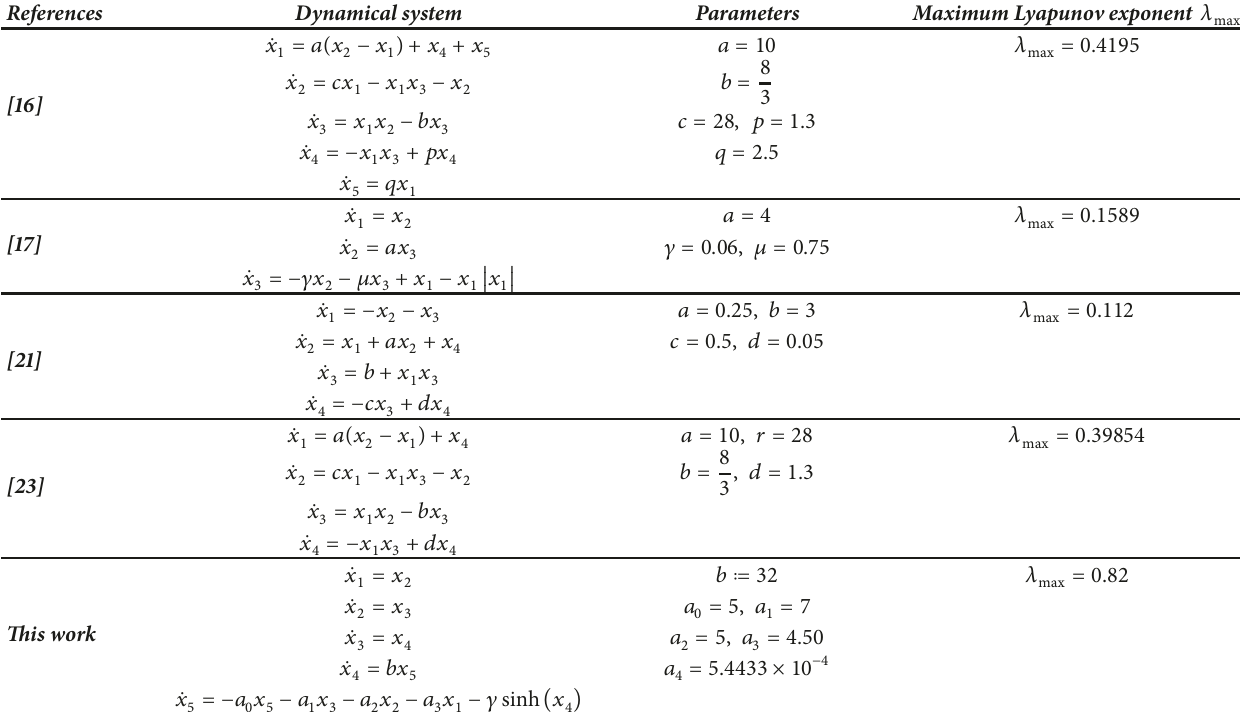
Table 1: Comparative analysis of some dynamical systems by using the largest Lyapunov exponent ( 𝜆 max).